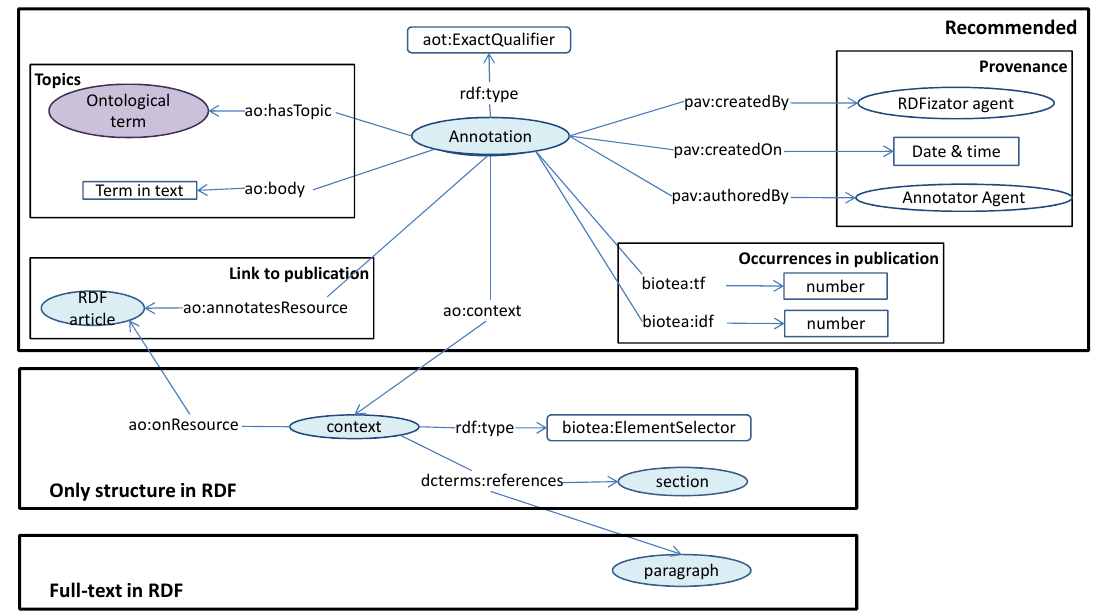
Figure 4. Model used for describing annotations according to the Annotation Ontology. Core concepts in the model are marked in blue. The ontology terms marked in purple are provided by the annotator. Adapted from